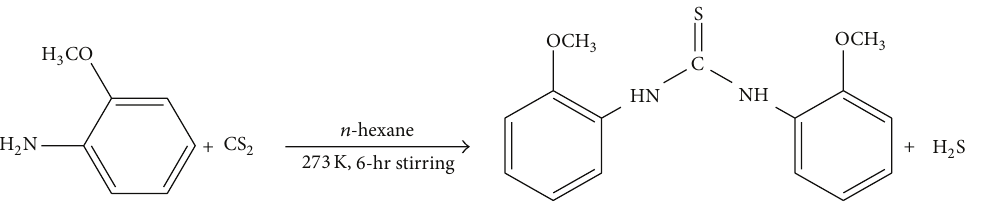
Scheme 1: Synthesis of the substituted